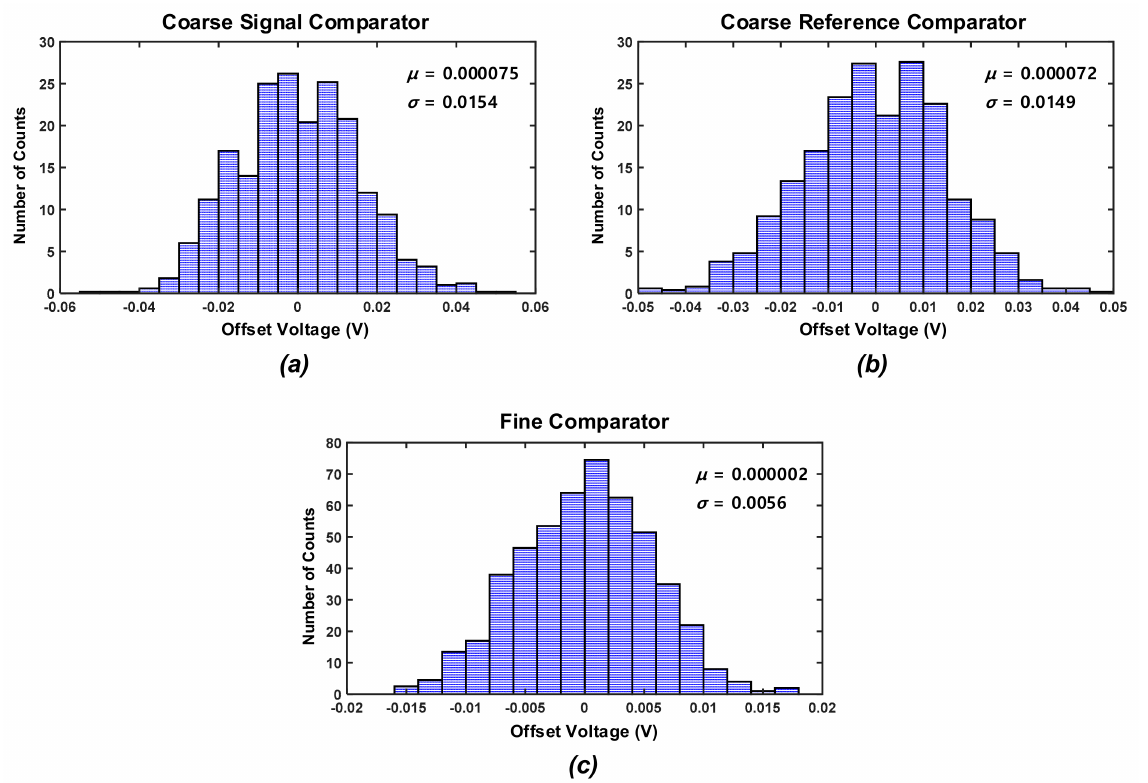
Figure 11. Histograms of the ( a ) coarse signal comparator, ( b ) coarse reference comparator, and ( c ) fine comparator offset voltage from Monte Carlo simulations with 1000 cases.